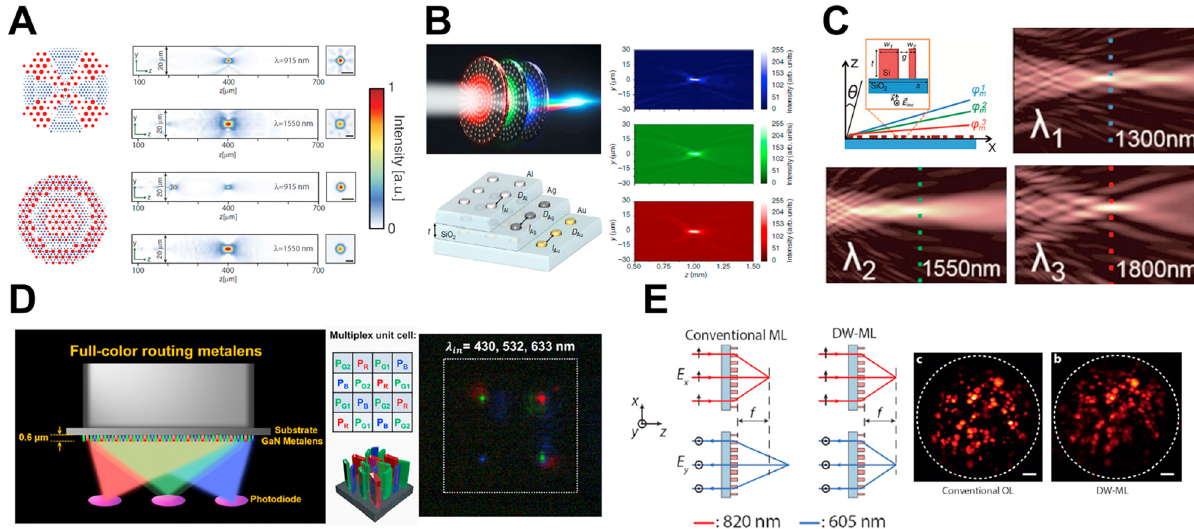
Figure 10: Multiwavelength metalenses. (A) Dielectric metasurface with in-plane spatial multiplex. Left panels show two spatial multiplexing schemes:lensaperturedivisionintoppanelandinterleavingofmeta-atomsinbottompanel.Rightpanelsshowmeasuredintensityprofilesat two different wavelengths. Adapted from Ref. [126]. Copyright 2016, The Authors. Distributed under a Creative Commons Attribution 4.0 International License (CC BY). (B) Metalens with out-of-plane spatial multiplexing. Left panels show the schematics and right panelsillustrate intensity pro fi les at three target wavelengths. Adapted from Ref. [132]. Copyright 2017, The Authors. Distributed under a Creative Commons Attribution 4.0 International License (CC BY). (C) Metalens with dispersion-engineered dielectric motifs. Top-left panel shows schematics of structure and required phases at different wavelengths. Remaining panels show intensity pro fi les at three target wavelengths. Adapted with permissionfromRef.[135].Copyright2015,AmericanAssociationfortheAdvancementofScience.(D)Metalensfortri-colorrouting.Leftpanel describes the application concept and middle panel shows how building blocks are arranged. Right fi gure shows measured results in focal plane. Adapted with permission from Ref. [129]. Copyright 2017, American Chemical Society. (E) Dual-wavelength metalens for two-photon microscopy [137]. Left panel provides working principle and right panels compare measured images for a conventional lens and dual- wavelength metalens. Adapted with permission from Ref. [137]. Copyright 2018, American Chemical